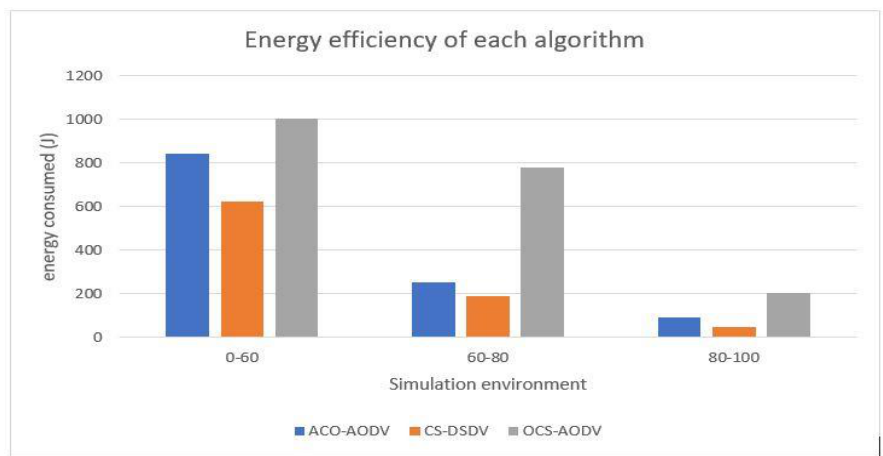
Figure 5. Energy consumption of the three routing protocols during the three time intervals.